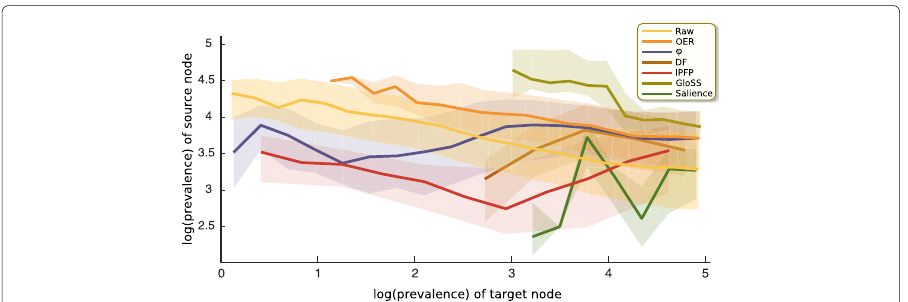
Fig. 6 Comparing prevalences of neighboring nodes. The horizontal axis pertains to the prevalence of the diseases, and the vertical axis depicts the distribution of the prevalences of their in-neighbors. The thick lines denote median values and the shades demarcate 0.25 and 0.75 quantiles. The axes are